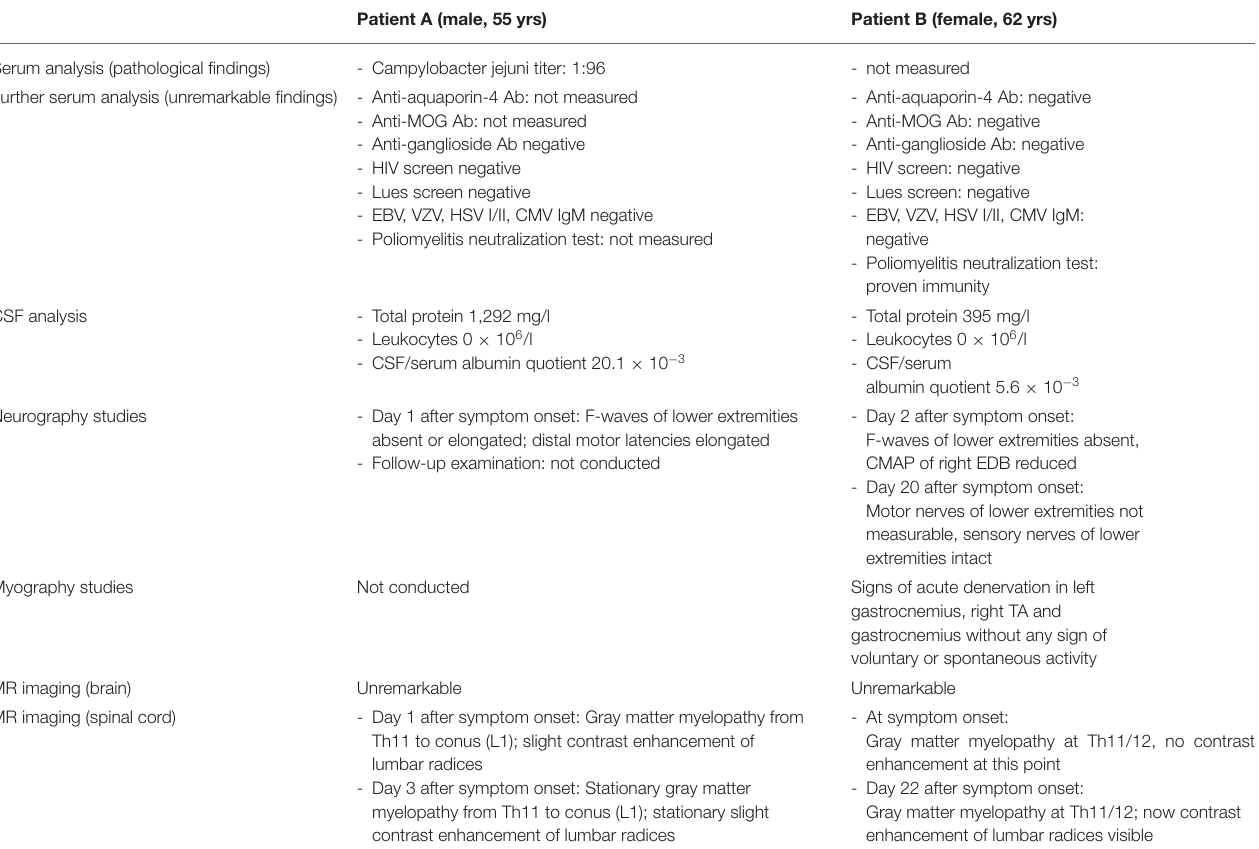
TABLE 1 | Overview of diagnostic measures applied to both